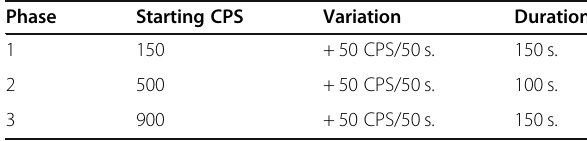
Table 3 IMS2, Cycle 1